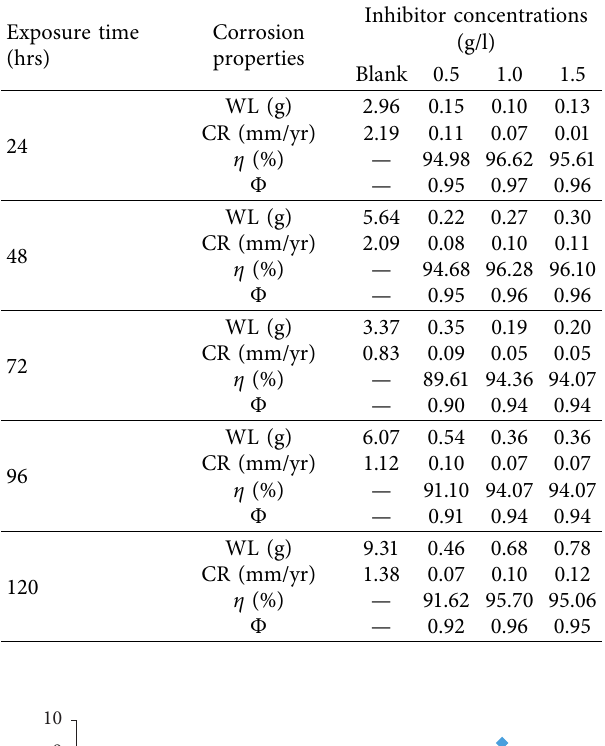
Table 1: Weight loss (g) of mebendazole in dilute H inhibitor concentrations and exposure times.